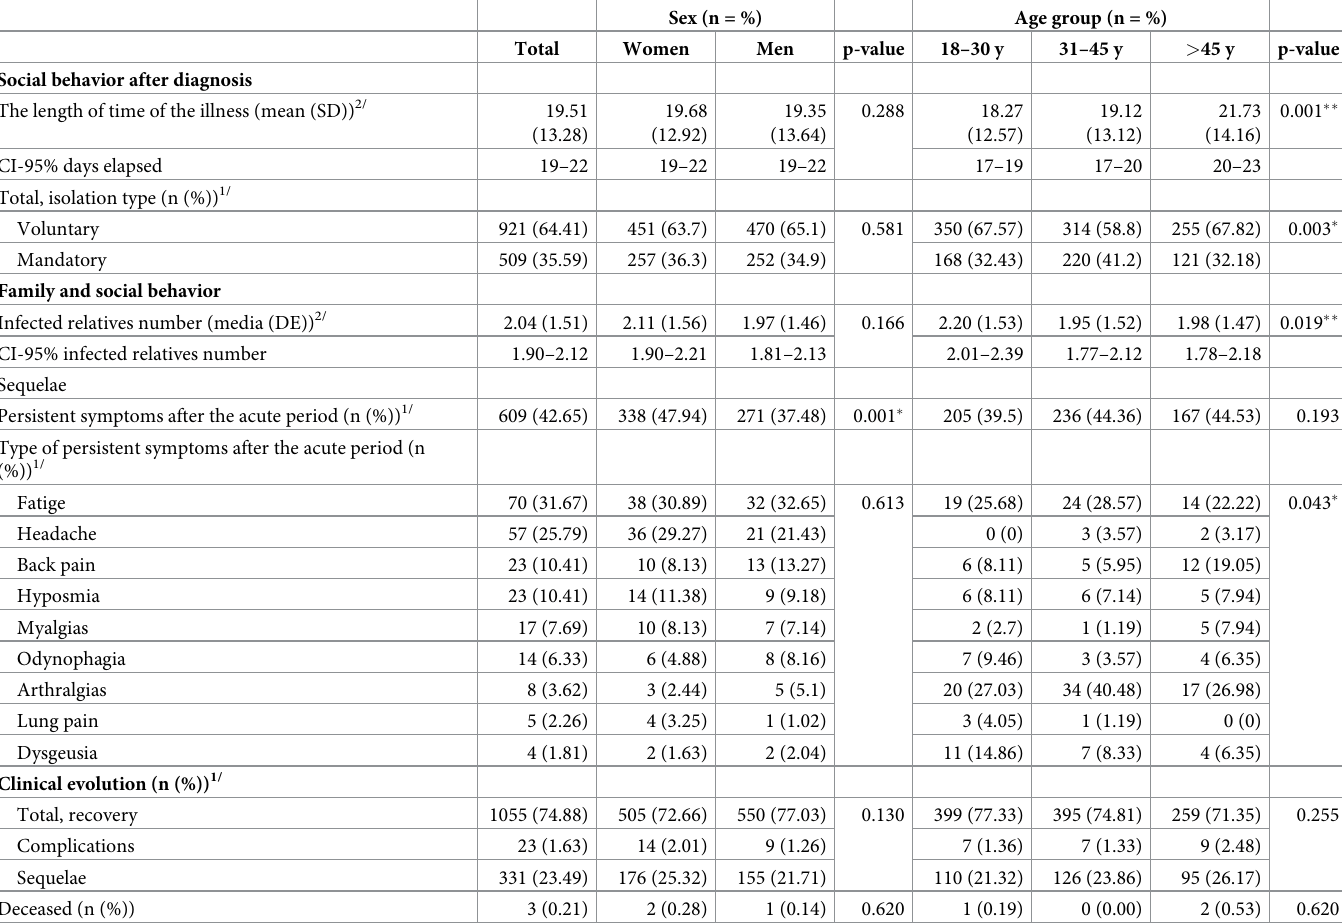
Table 2. Distribution of non-hospitalized patients infected with COVID-19 according to sex, age group, behavior after diagnosis, family and social behavior, sequelae, and clinical